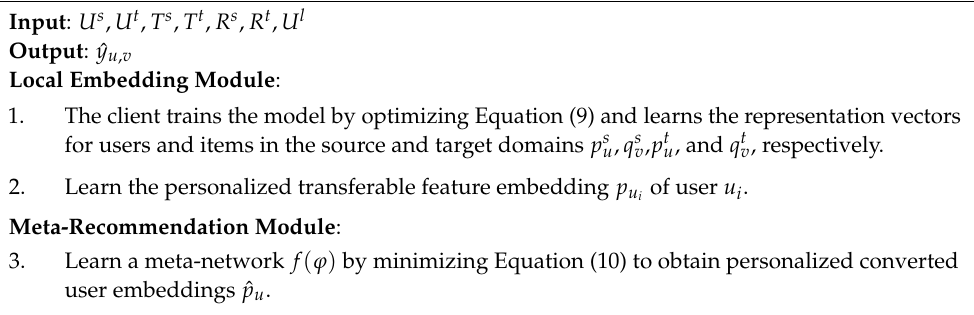
Algorithm 1: A meta-learning-based model for federated personalized cross-domain